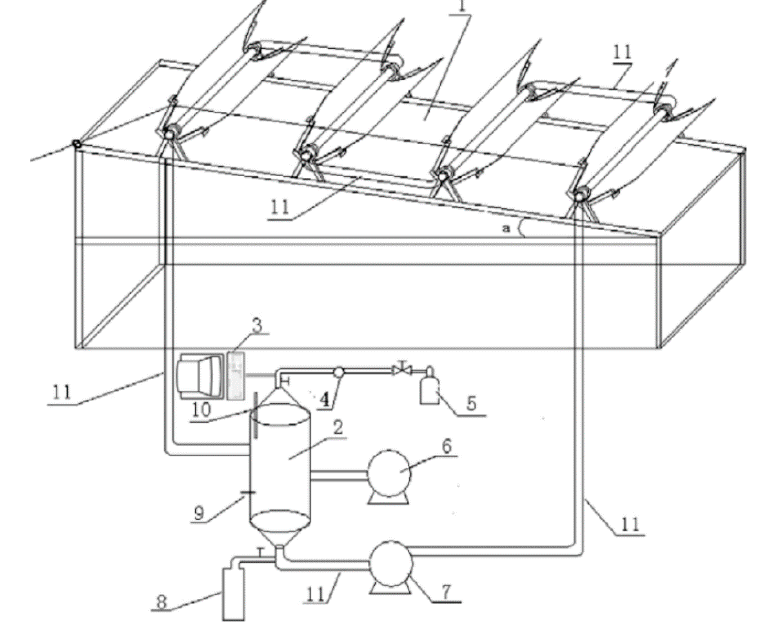
Figure 37. Flow chart of the photocatalytic hydrogen production solar reactor. (1) Support, (2) storage tank, (3) gas chromatography, (4) gas flow meter, (5) gas collection apparatus, (6) feeding pump, (7)